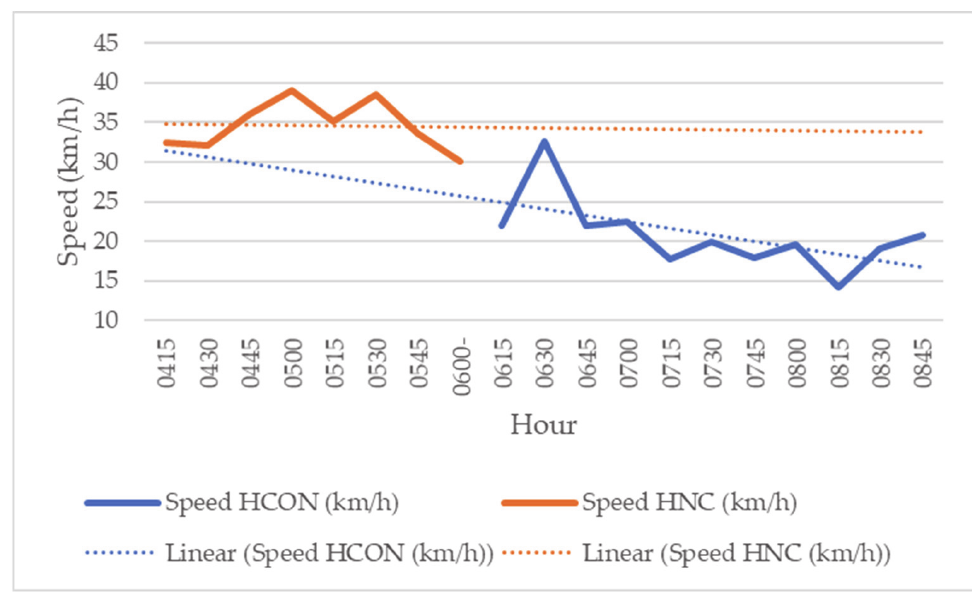
Figure 6. Speed HCON vs. HNC.